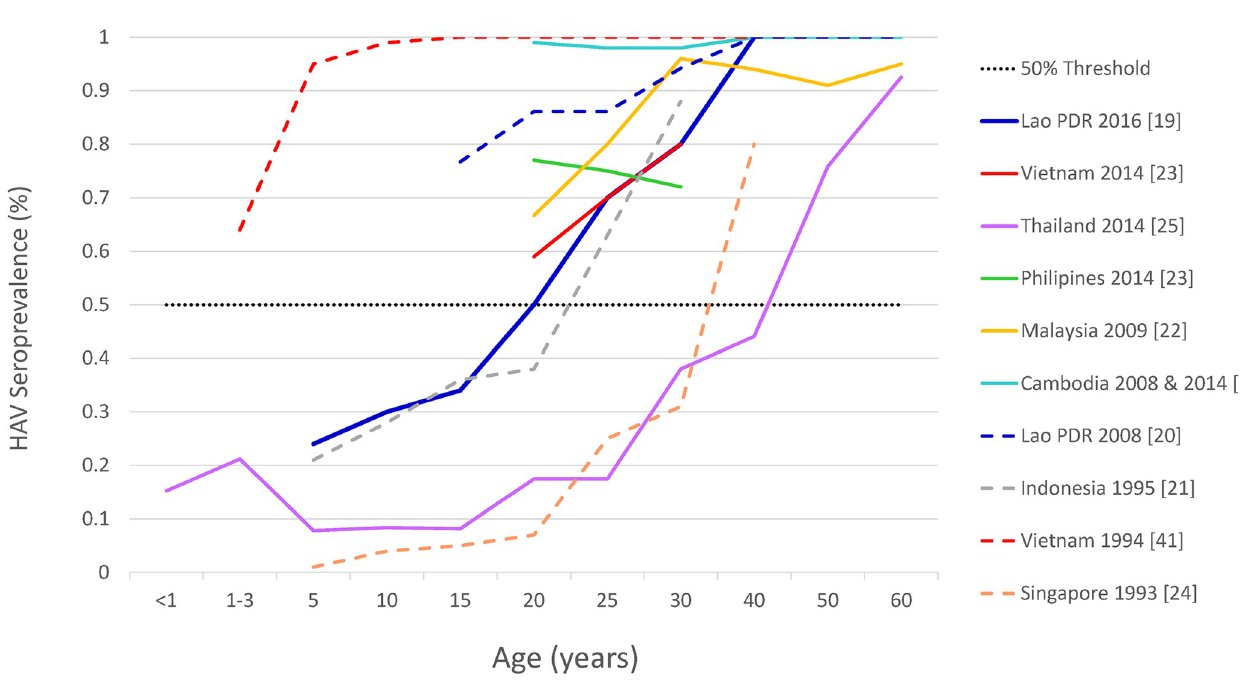
Fig 3. Age specific trends in HAV Seroprevalence from ASEAN countries (1999–2020) (n = 10). Note: The dotted line represents the 50% threshold to visually categorize HAV endemicity. Only latest information from Thailand is depicted intentionally. Abbreviations: ASEAN, Association of Southeast Asian nations; HAV, hepatitis A virus.